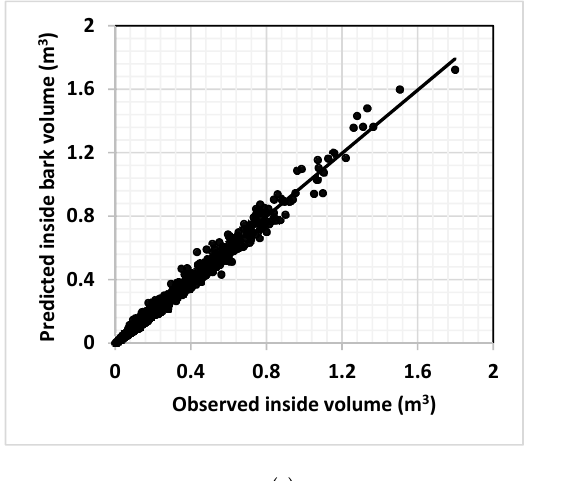
Figure 1. Scatterplots of the ratio of outside bark to inside bark volumes estimated using Equation (10) against inside bark volumes for ( a ) jack pine, ( b ) black spruce, ( c ) balsam fir, and ( d ) sugar maple. Estimated inside and outside bark volumes were also plotted against their observed counterparts for all tree species. Estimated volumes were randomly clustered around the 1:1 line for both inside (Figure 2) and outside bark (Figure 3) volumes for all tree species. Example plots are included for jack pine, black spruce, balsam fir, and sugar maple rep- eastern white cedar. resenting pine, spruce, fir, and other hardwood species, respectively.